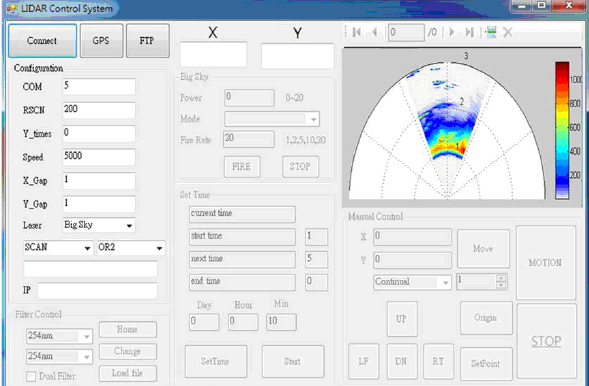
Figure 4. The interface control program of the lidar